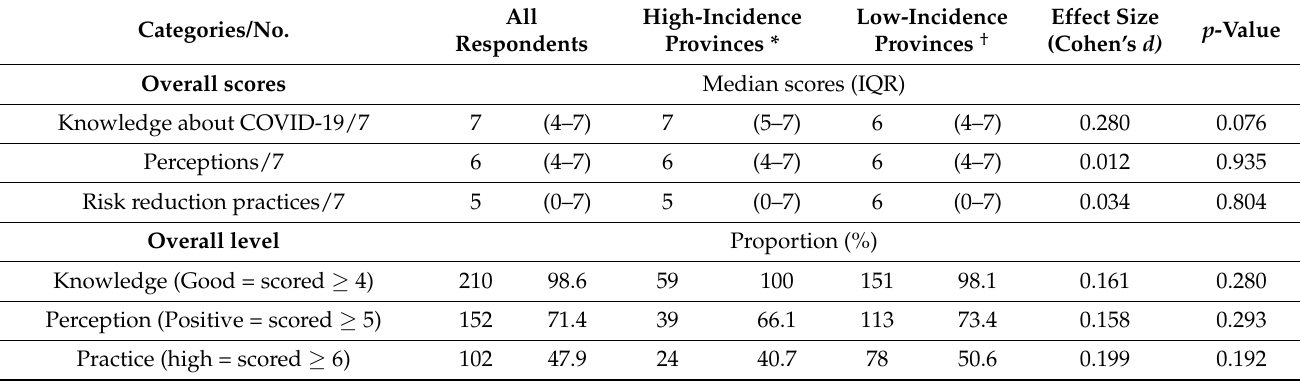
Table 4. Summary results of the knowledge, perceptions, and practices survey—Afghanistan, 14–22 April 2020.